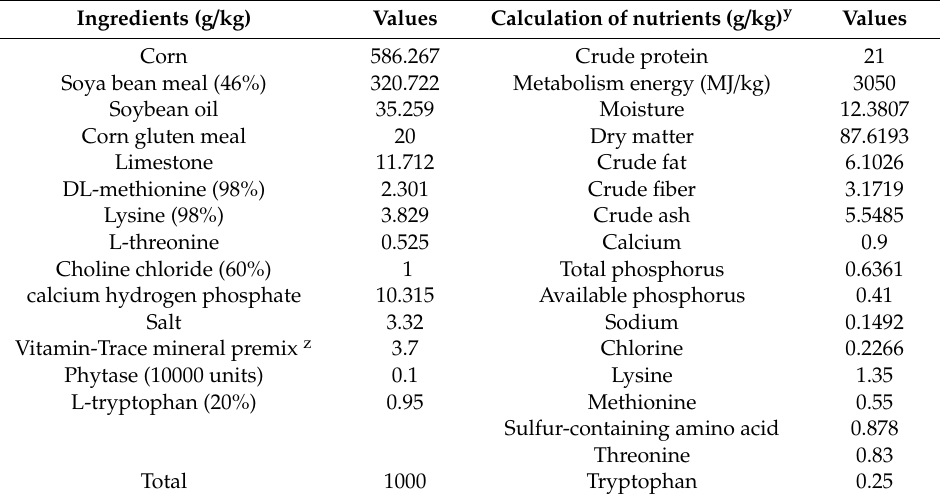
Table 1. Ingredients and nutrient composition of the basal